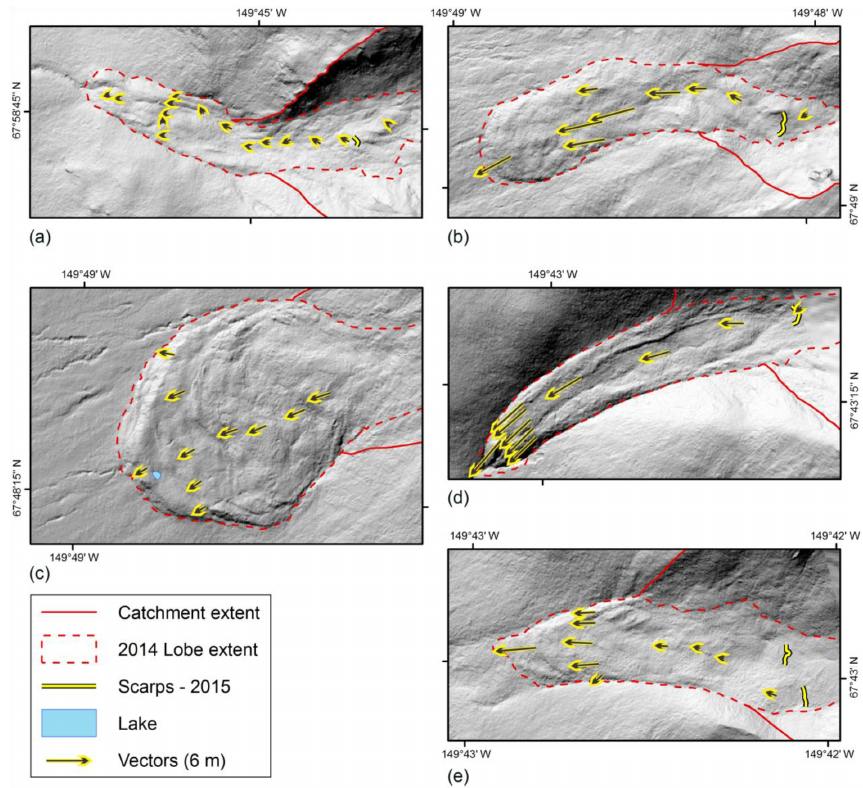
Figure 6. Vector maps of (a) FDL-11, (b) FDL-B, (c) FDL-C, (d) FDL-5, and (e) FDL-4 summarizing movement measured from June 2013 to August 2015, and scarp locations. The scale of each image is 1:10000. Vectors are scaled from the 6m scale included in the legend. As the base maps are from 2011 lidar data (Hubbard et al., 2011), the 2014 FDL extents also are shown. Base maps also include data from GINA